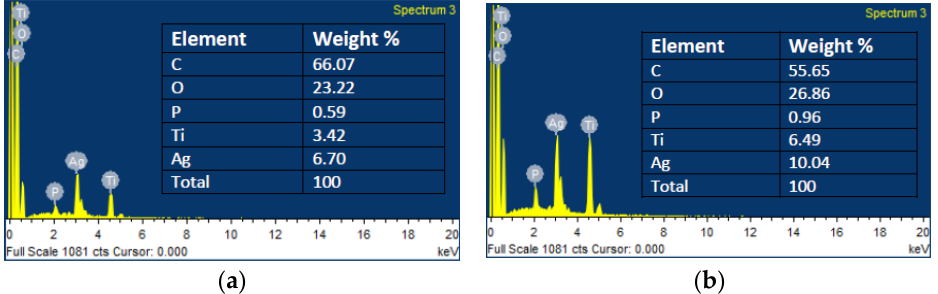
Figure 3. EDX spectra of PMMA/PVP-Ag 3 PO 4 /P25 nanofibers before ( a ) and after washing ( b ).